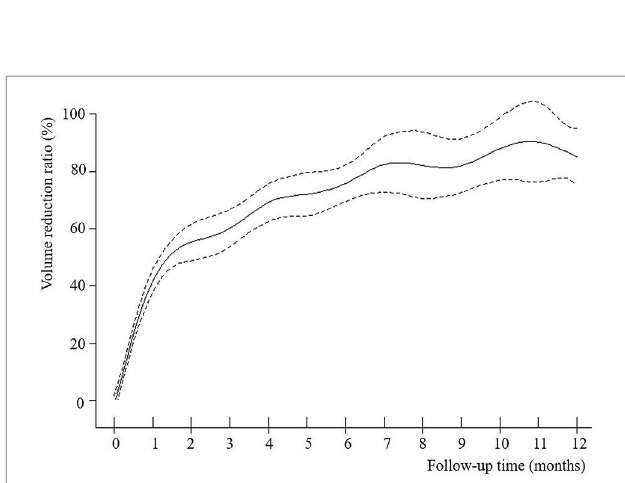
FIGURE 3 VRR-Time fi tting curve for “ BTN+HT ” group. BTN, benign thyroid nodule; HT, Hashimoto ’ s thyroiditis; VRR, volume reduction